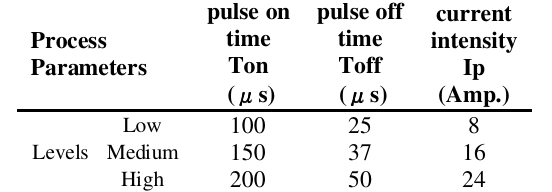
Fig. 1. EDM Tool Model CM 323C